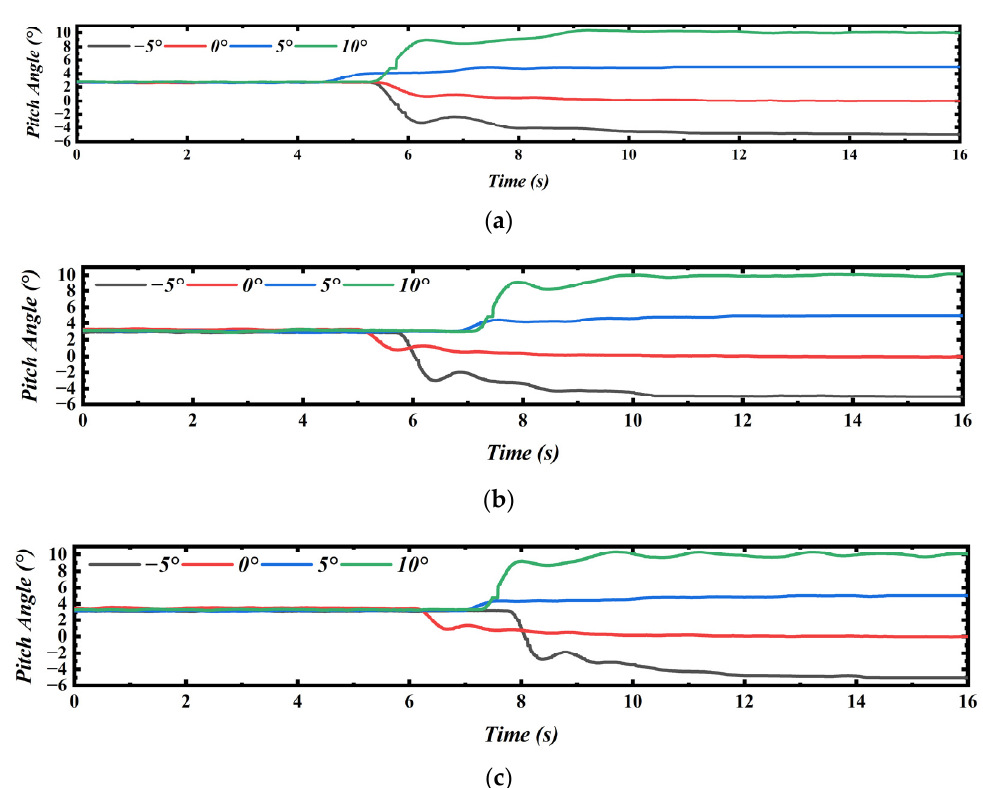
Figure 25. Pitch angle control time history curves at different wind speeds: ( a ) 16 m/s; ( b ) 20 m/s; and ( c ) 24 m/s.